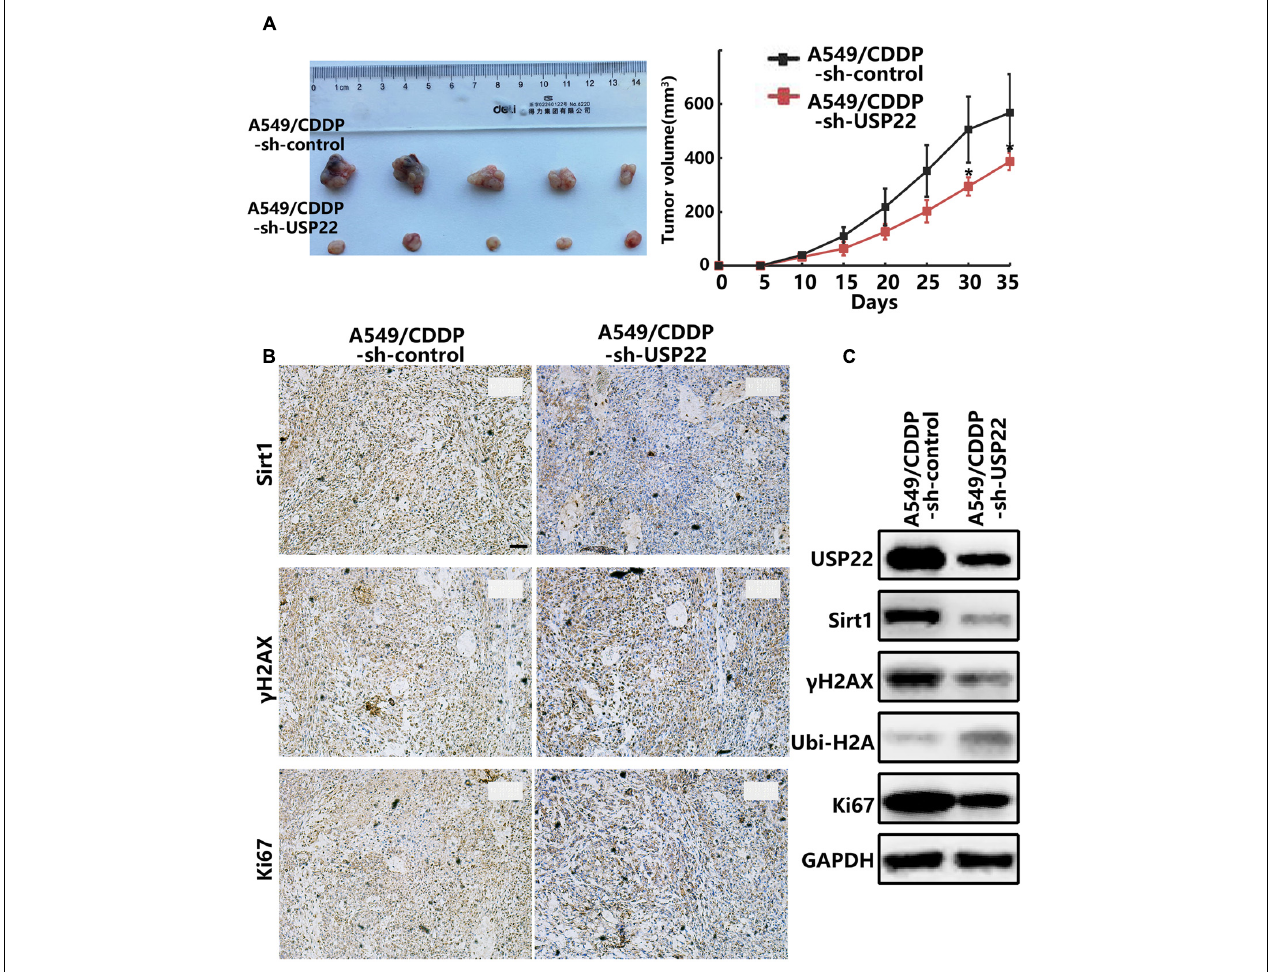
FIGURE 6 | Inhibiting USP22 expression enhanced cisplatin sensitivity in cisplatin-resistant A549/CDDP cell nude mouse xenografts. (A) Representative figures and growth curve of tumor by subcutaneous injection of A549/CDDP and A549/CDDP-sh-USP22 cells. (B) IHC staining of Sirt1, γ H2AX and Ki67 in tumor nodules from A549/CDDP and A549/CDDP-sh-USP22 cells derived xenografts. Bar: 200 µ m. (C) Western blot analysis of USP22, Sirt1, γ H2AX, Ubi-H2A, and Ki67 in A549/CDDP and A549/CDDP-sh-USP22 cells derived xenografts. Every experiment was conducted at least three times, and the average is shown (mean ± SD). ∗ P < 0.05, ∗∗ P < 0.01,